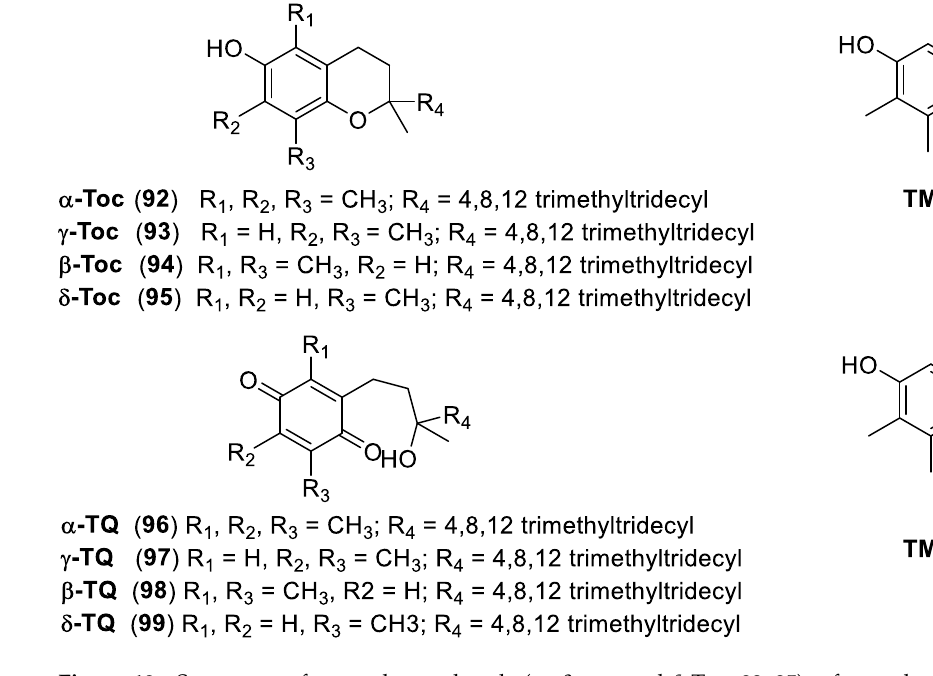
Figure 19. Structures of natural tocopherols (α, β, γ-, and δ-Toc, 92 – 95 ), of tocopheryl quinones (α, β, γ -, and δ-TQ, 96 – 99 ), and low molecular weight analogs ( 100 and 101 ).